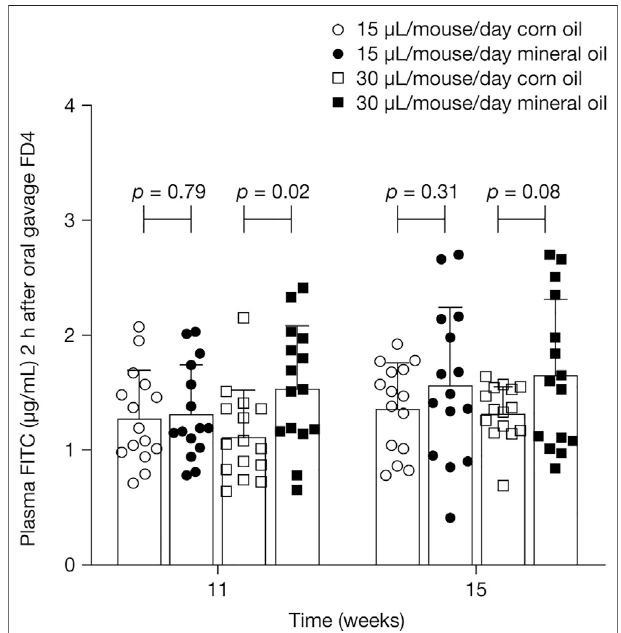
FIGURE 1 | Mean (SD) plasma concentrations of FITC-dextran 4 kDa 2 h after oral administration of FITC-dextran at 11 and 15 weeks. p -values were calculated using independent samples t -test. FD4, FITC-dextran 4 kDa; SD, standard